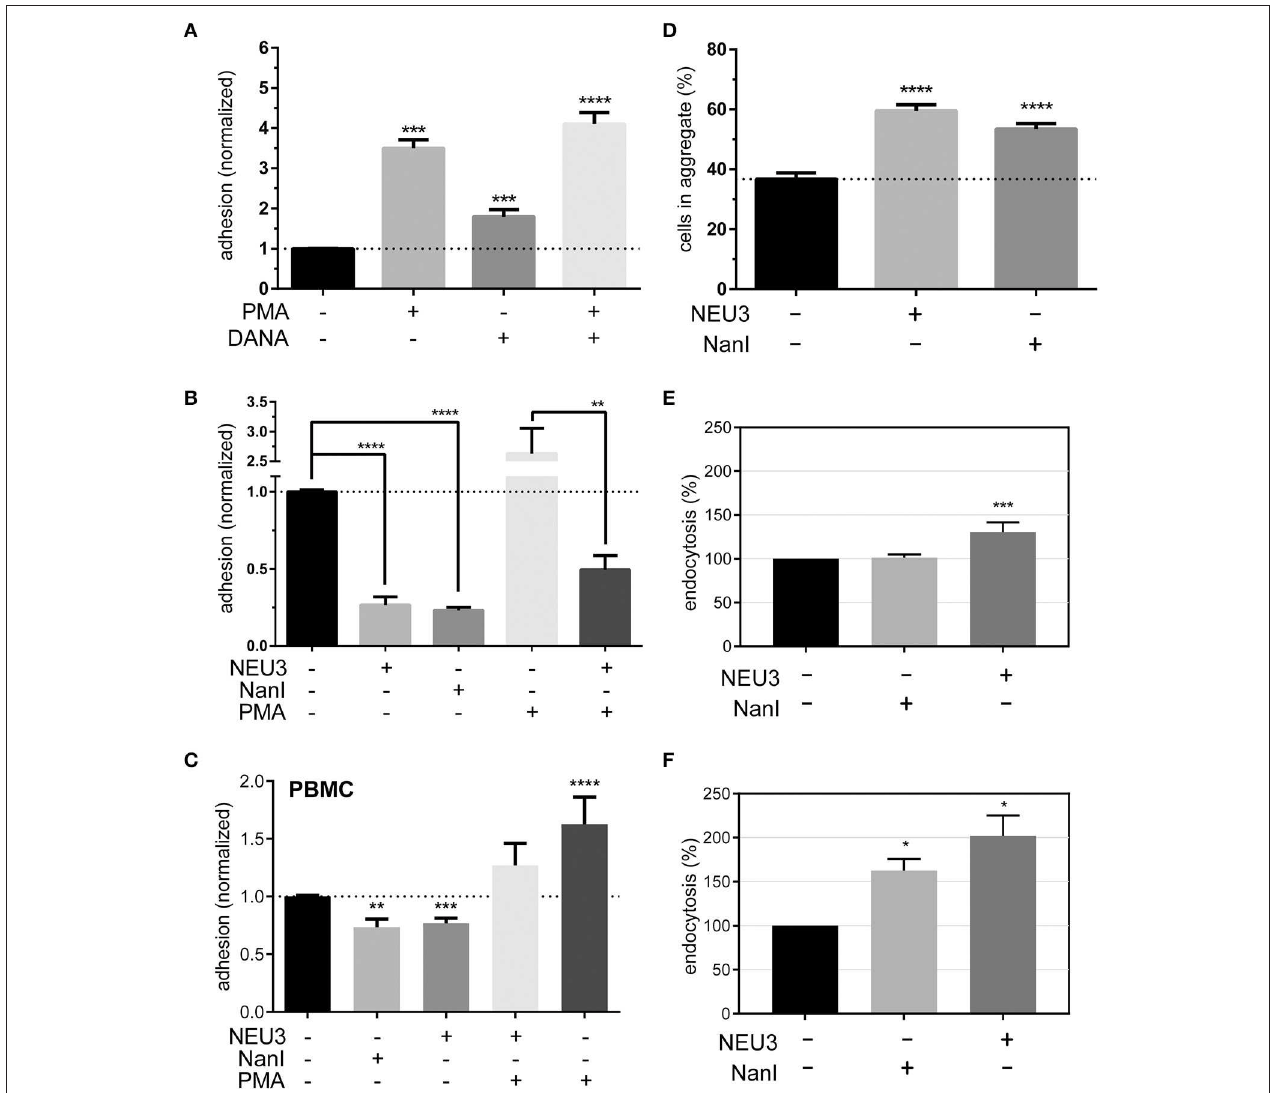
FIGURE 6 | Adhesion of T cells is altered by Neu treatment. (A) Adhesion of Jurkat cells to ICAM-1 was determined using flow cytometry and fluorescent beads (1 µ m) under the indicated conditions. Control samples were treated with DMSO (0.05 %), PMA, or DANA for 30min. (B) Adhesion of Jurkat cells to ICAM-1 was determined using flow cytometry and fluorescent beads; samples were treated with buffer or enzyme for 3h, followed by incubation with buffer, PMA, or DANA (100 µ M) for 30min. All cytometry data were normalized to the appropriate control after background subtraction (BSA coated beads). (C) Isolated PBMC were treated as indicated and adhesion to ICAM-1 coated beads was determined by flow cytometry. Data shown are from at least three healthy donors for each condition. Values shown in (A–C) are the average of N = 6–12 replicates, error is the standard error of the mean. (D) Homotypic aggregation of Jurkat cells was determined using microscopy. Cells were incubated under the indicated conditions for 3h. Aggregation was determined by imaging to determine the total number of cells and the number of cells found within aggregates. Aggregation is expressed as the percentage of cells in all samples found within an aggregate ( N = 24, from two separate experiments), and error is shown as the standard error of the mean. (E) Changes in the endocytosis of β 2-integrin ( N = 4) and (F) β 1-integrin ( N = 2) in Jurkat cells after treatment with NanI or NEU3 (30min at 37 ◦ C). Error bars are shown as standard error of the mean, all data were compared to the indicated control using a t